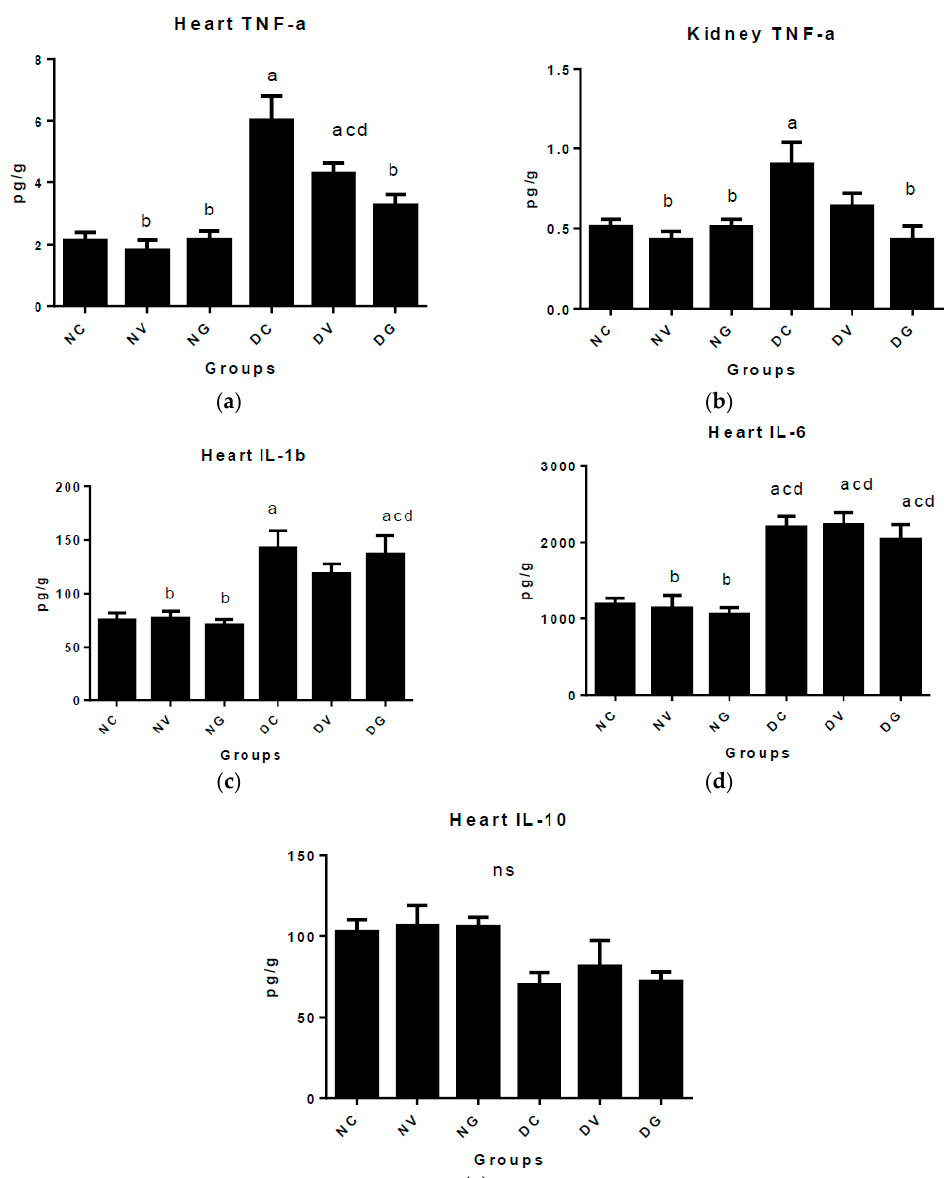
Figure 3. Effect of vindoline on levels of inflammatory cytokines in the heart and kidney tissues after 6-week treatment period represented by the following subfigures; ( a ) heart TNF- α ; ( b ) kidney TNF- α ; ( c ) heart IL-1 β ; ( d ) heart IL-6 and ( e ) heart IL-10. Data represented as means ± SEM. a p < 0.05 vs. normal control. b p < 0.05 vs. diabetic control. NC: normal control; NV: normal control treated with